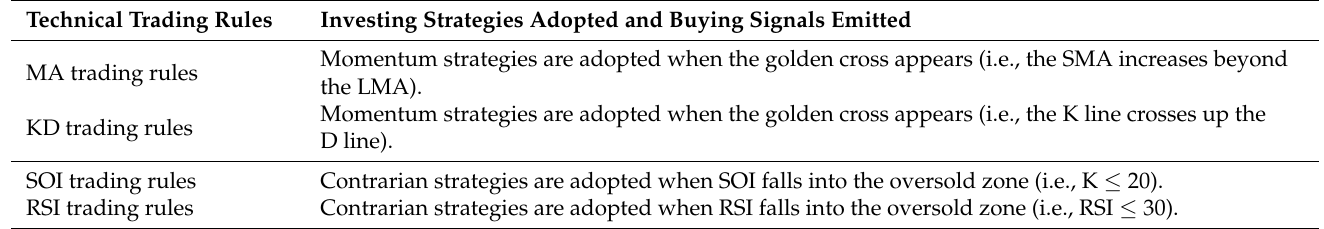
Table 1. Technical trading signals in terms of momentum and contrarian strategies. Technical Trading Rules Investing Strategies Adopted and Buying Signals Emitted MA trading